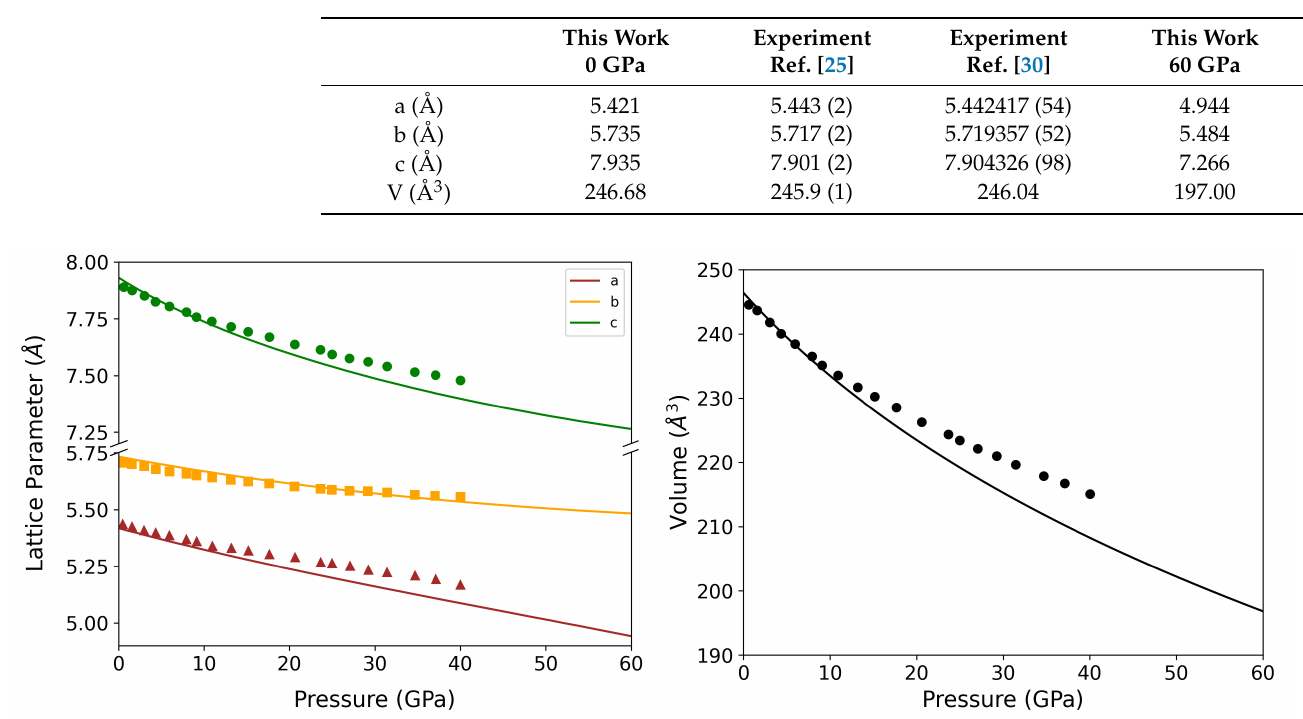
Figure 1. The structure of DyScO 3 is of the orthorhombic perovskite type. In this plot the ScO6 octahedra of the structure are shown in magenta, with oxygen sites (in red) at their corners and Sc sites at the centers. The Dy cation sites are shown in blue. Table 1. Calculated and experimental lattice parameters and unit cell volume at 0 GPa. Also provided are the calculated values at 60 GPa, for reference.